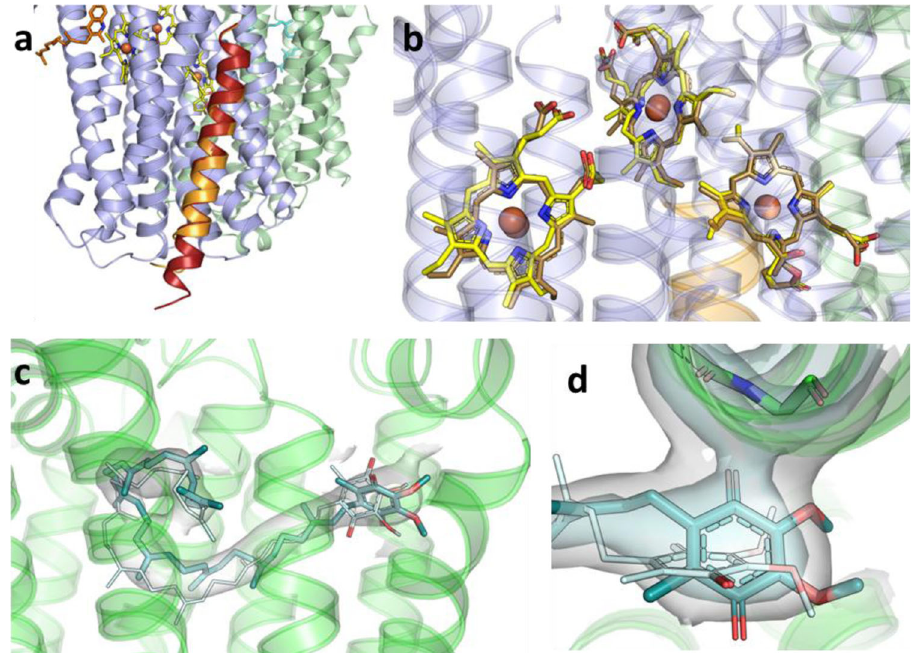
Fig. 6 Structural similarities between E. coli bd -I and bd -II. a Superposition of the small subunits AppX (orange) and CydX (red). b Superposition of the heme groups. c Superposition of ubiquinone-8 in E. coli bd -II (gray, oxygen in red) and bd -I (blue, oxygen in red). The Coulomb density map is shown as surface at 1.0 σ (carved at a radius of 2.4 Å around model atom centers). d Close-up view of the positioning of the headgroup of ubiquinone-8 in bd -I (pale cyan lines) and in bd -II (teal sticks). bd -II subunit AppB is shown as cartoon. The Coulomb density is given for ubiquinone-8 (bound to AppB) and for neighboring amino acids Ala218 B and Gly219 B of AppB at σ -levels of 1.2 (pale cyan) and 2.0 (light gray), both carved at 2.3 Å radius around model atom